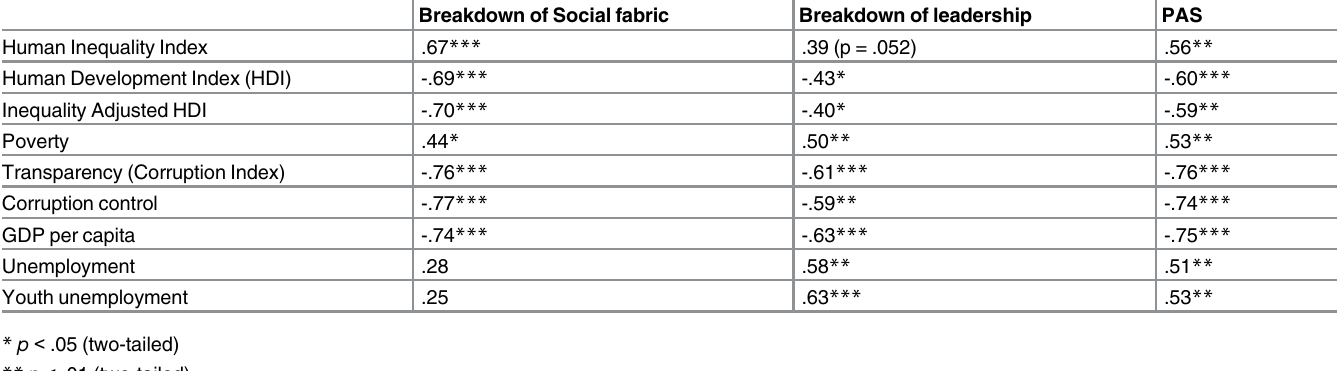
Table 5. Bivariate correlation between country-level indicators of the social and economic stability and PAS at the country-level (N = 30). Breakdown of Social